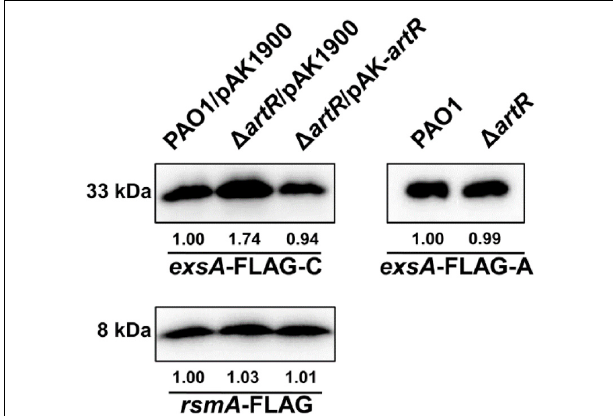
FIGURE 4 | ArtR doesn’t influence the translation process of ExsA. Western-blotting showed the expression levels of ExsA-FLAG and RsmA-FLAG in PAO1 and the artR mutant. The exsA -FLAG-C fusion contained the promoter region of the exsCEBA operon and the exsA coding region. The exsA -FLAG-A fusion carried the tac promoter and the exsA coding region. The rsmA -FLAG fusion contained the promoter region and coding region of rsmA . The pAK1900 plasmid carrying the entire artR gene and the promoter region of artR was used for the complementation of (cid:49) artR . The bands of approximately 33 and 8 kDa were corresponding to ExsA-FLAG and RsmA-FLAG respectively. The relative grayscale value of ExsA-FLAG and RsmA-FLAG bands were quantified using ImageJ.